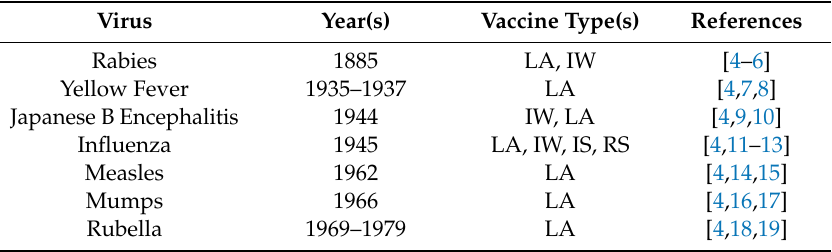
Table 1. Vaccines against ssRNA, membrane-enveloped